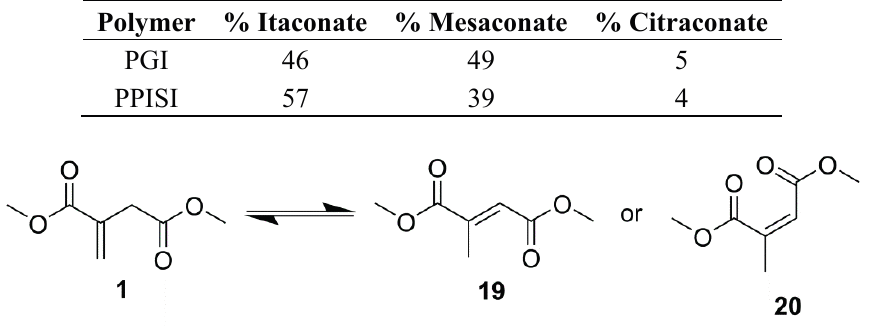
Table 3. %mol itaconate:mesaconate:citraconate for the PGI and PPISI backbones.